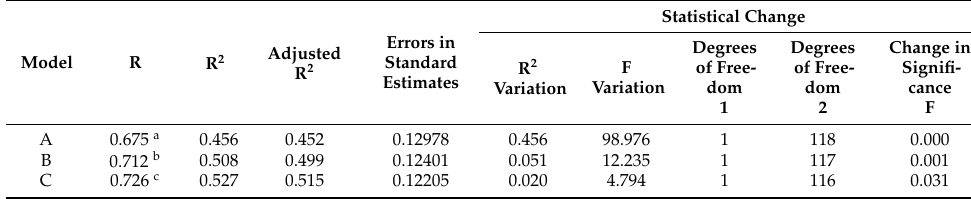
Table 3. Summary table of carbon stock estimation models d .